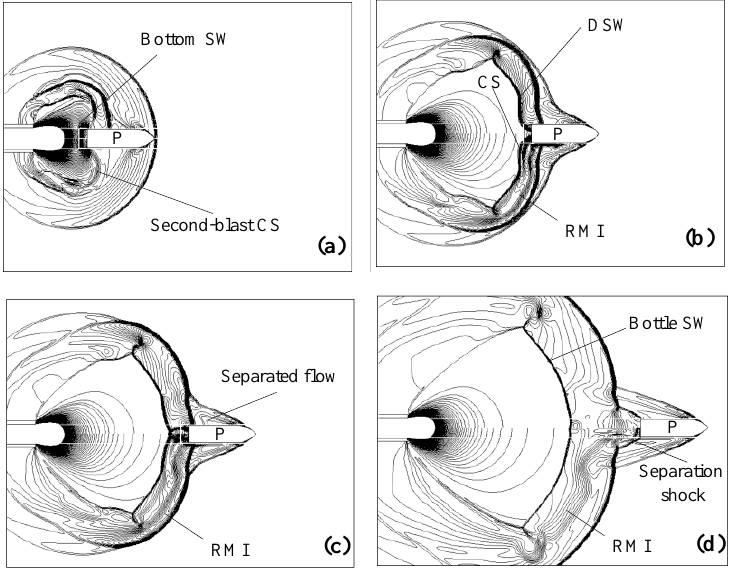
Figure 10. Isopycnic (the lower half) and isobars (the upper half) for blunt-ended projectile. ( a ) t = 0.736 ms; ( b ) t = 0.989 ms; ( c ) t = 1.091 ms; ( d ) t = 1.371 ms.